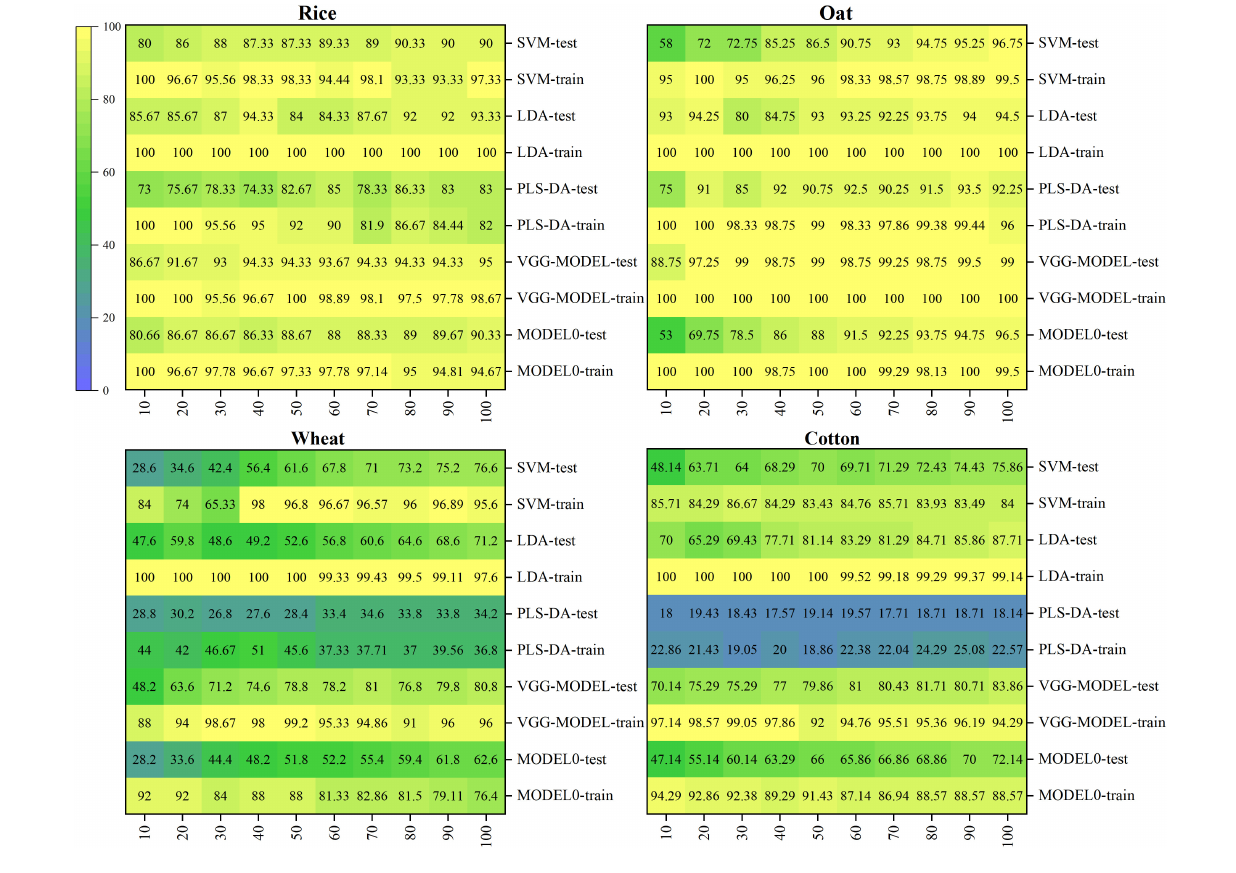
FIGURE 5 | The classification accuracies of all the models on the four target